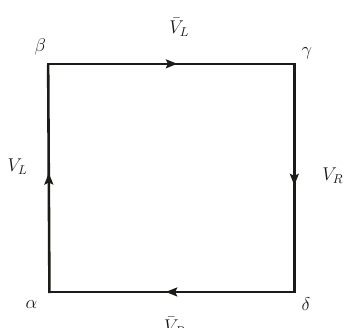
Figure 4. The Reggeon (cid:12)eld theory Hamiltonian H (1) color charge